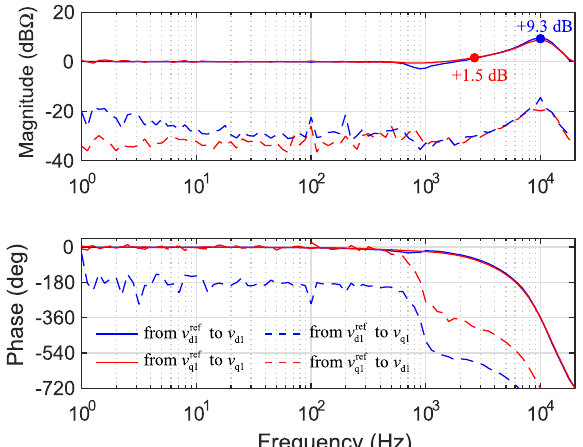
Figure 4. Measured frequency response of amplifier in internal voltage control mode when it is loaded by 50 A peak AC